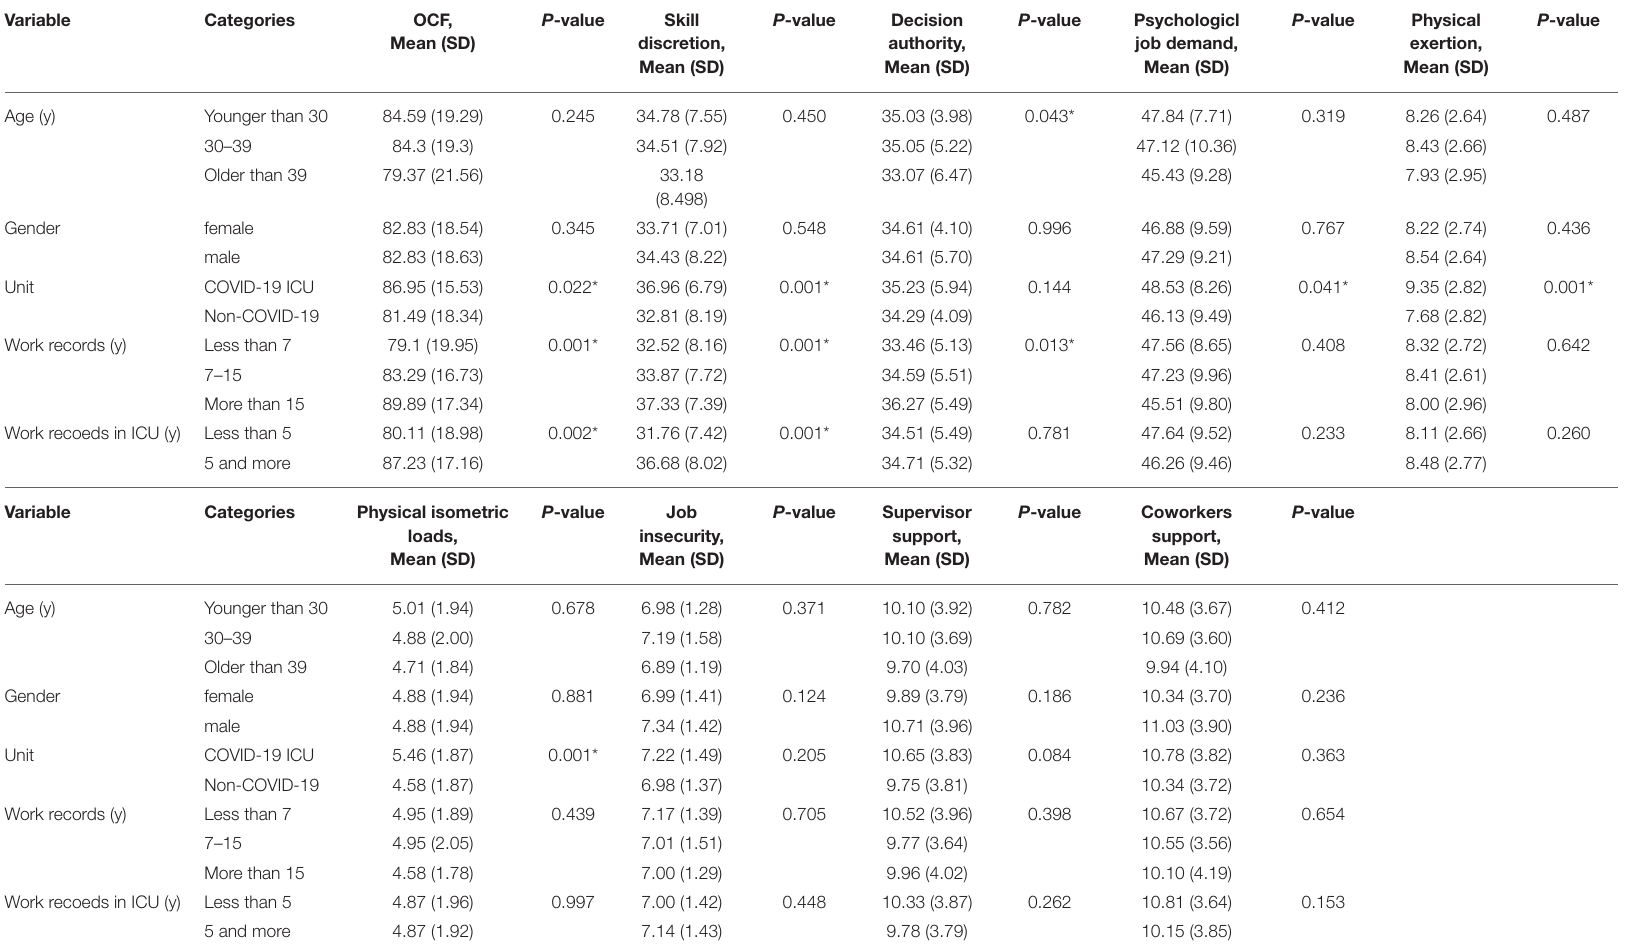
TABLE 4 | Association between JC, OCF, and characteristics of participants.